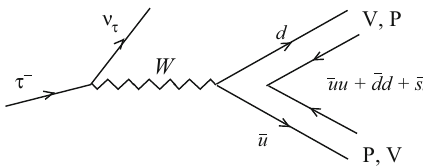
Fig. 2 Hadronization of the primary q ¯ q pair to produce a vector and pseudoscalar